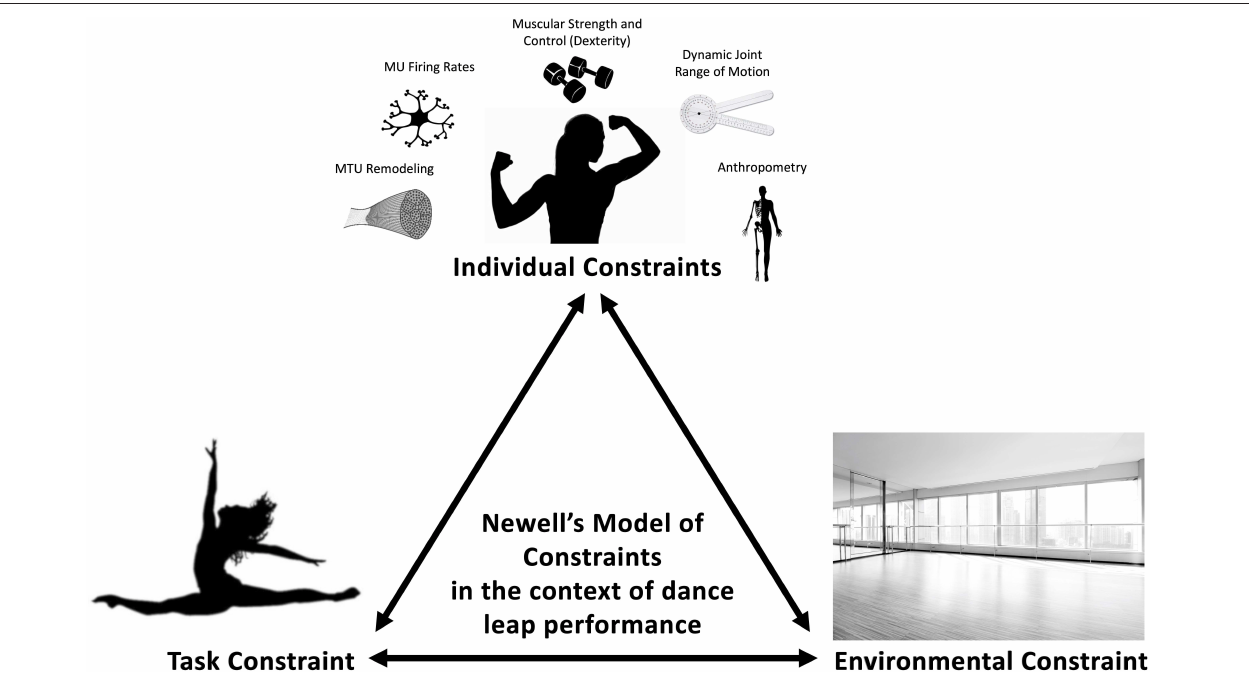
FIGURE 1 | Provides examples of modifiable individual constraints that may contribute to dance performance such as strength, dexterity, range of motion, motor unit firing rate, and MTU remodeling and non-modifiable factors such as skeletal anthropometry. The task constraint of leaps during dance performance requires the torso to remain upright for aesthetics. Finally, the type of flooring, which can interact with either individual or task constraints, within dance can be considered an environmental